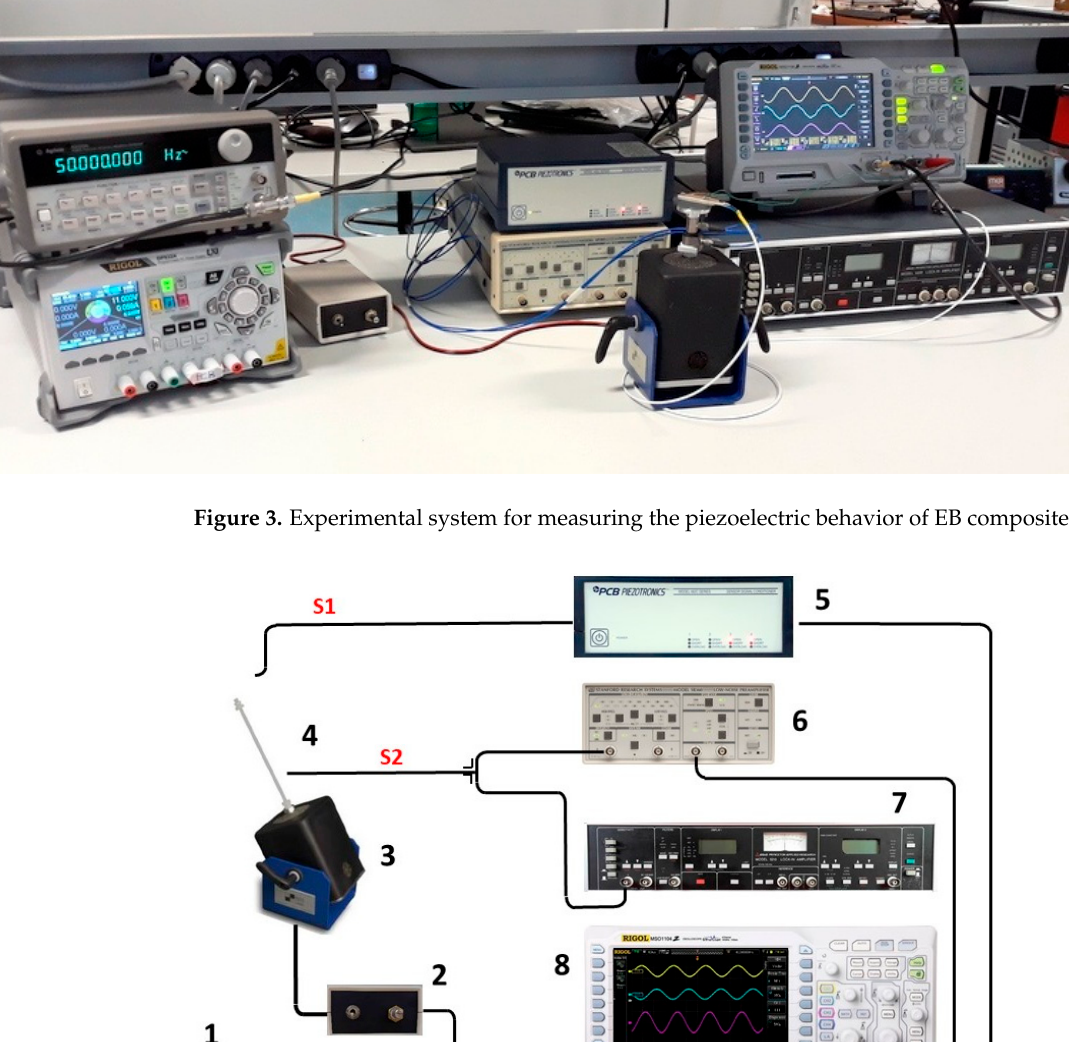
Figure 2. ( Left , up ) SEM micrograph of a typical laser-cut EB/ZFL film sample. ( Left , down ) Sample of EB/ZFL after the silver painting with a brush. The rectangular part on the left is clamped into the sample holder. ( Right ) View of the system used to clamp the sample under test (1,2) and the two sensors (3,4).